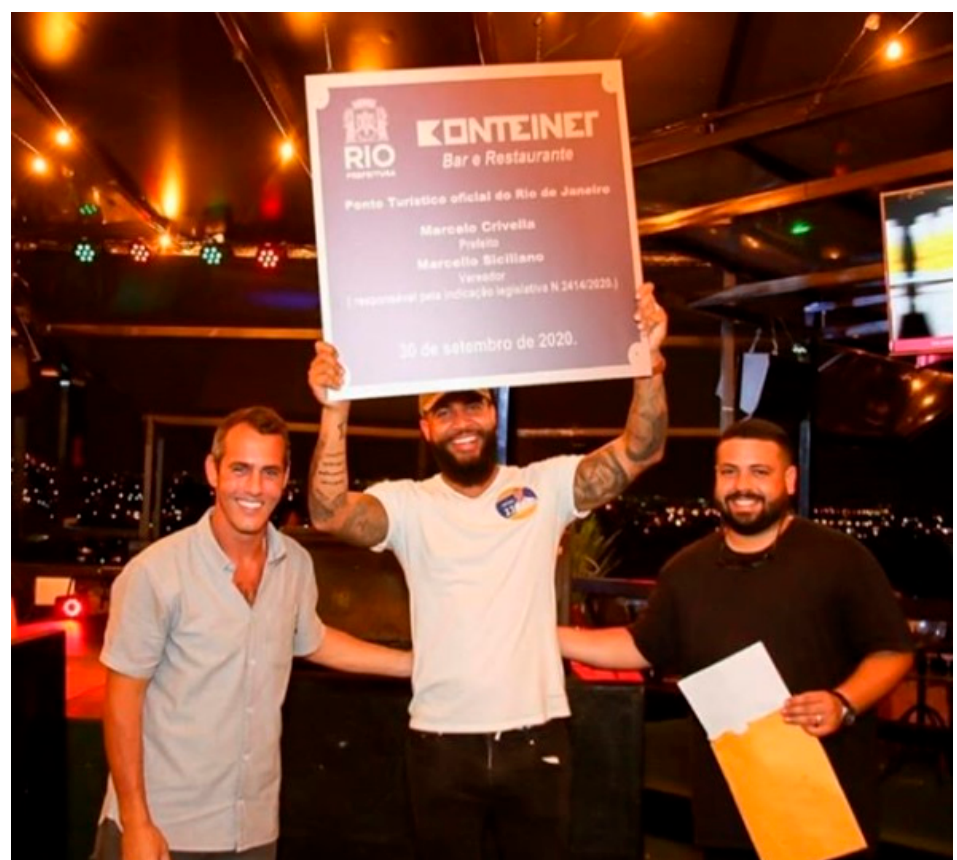
Figure 6. Konteiner receiving the official tourist spot sign by the city of Rio de Janeiro.